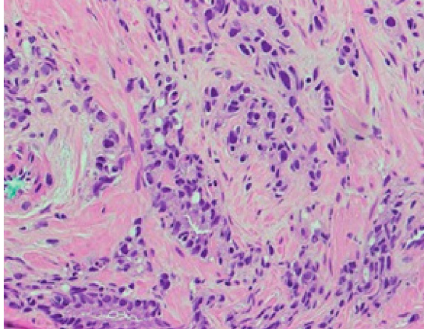
Figure 3: Hematoxylin and eosin staining showing acinar ade- nocarcinoma of the prostate featuring enlarged, pleomorphic cells infiltrating as solid nests and cords with poorly differentiated glands (Gleason score 5+4 �